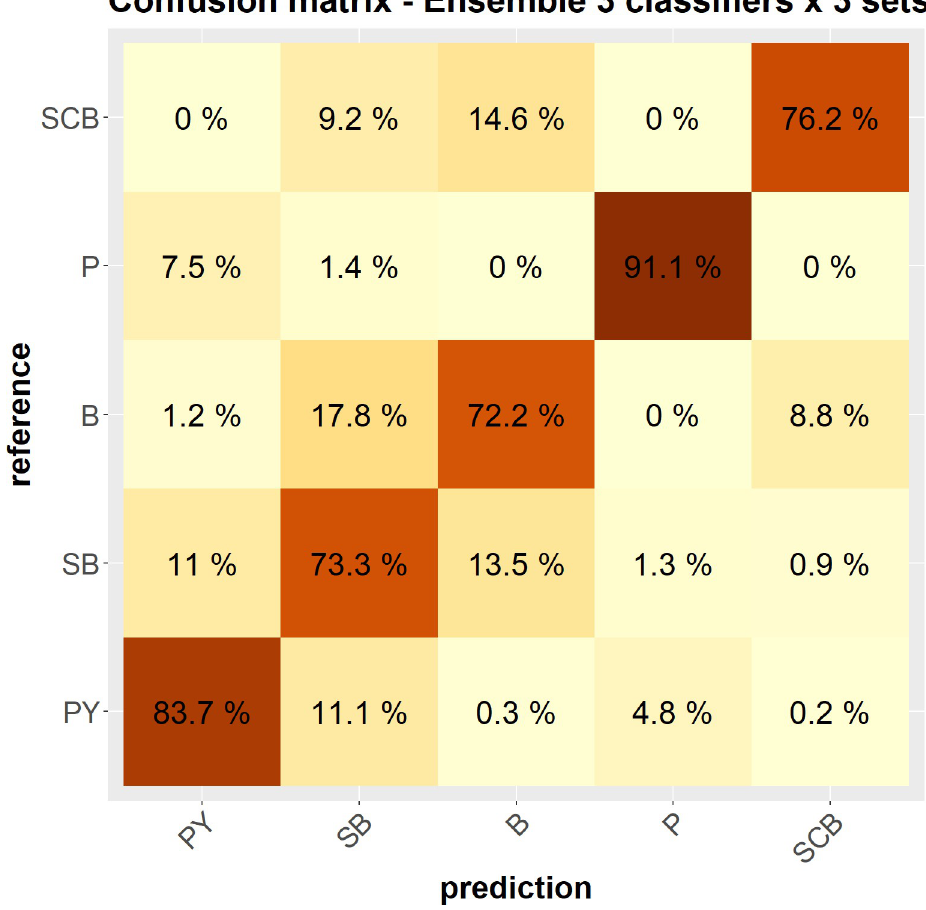
Fig 7. Average confusion matrix, for 100 iterations of the evaluation process, reporting the classification rates of the call types in the best configuration (the ensemble classifier combining the 9 primary classifiers). Types are sorted from bottom to top by decreasing number of occurrences (PY: most frequent; SCB: least frequent). Percentages are according to the reference and sum to 1 along rows. The value of a cell color is proportional to its percentage (the darker, the